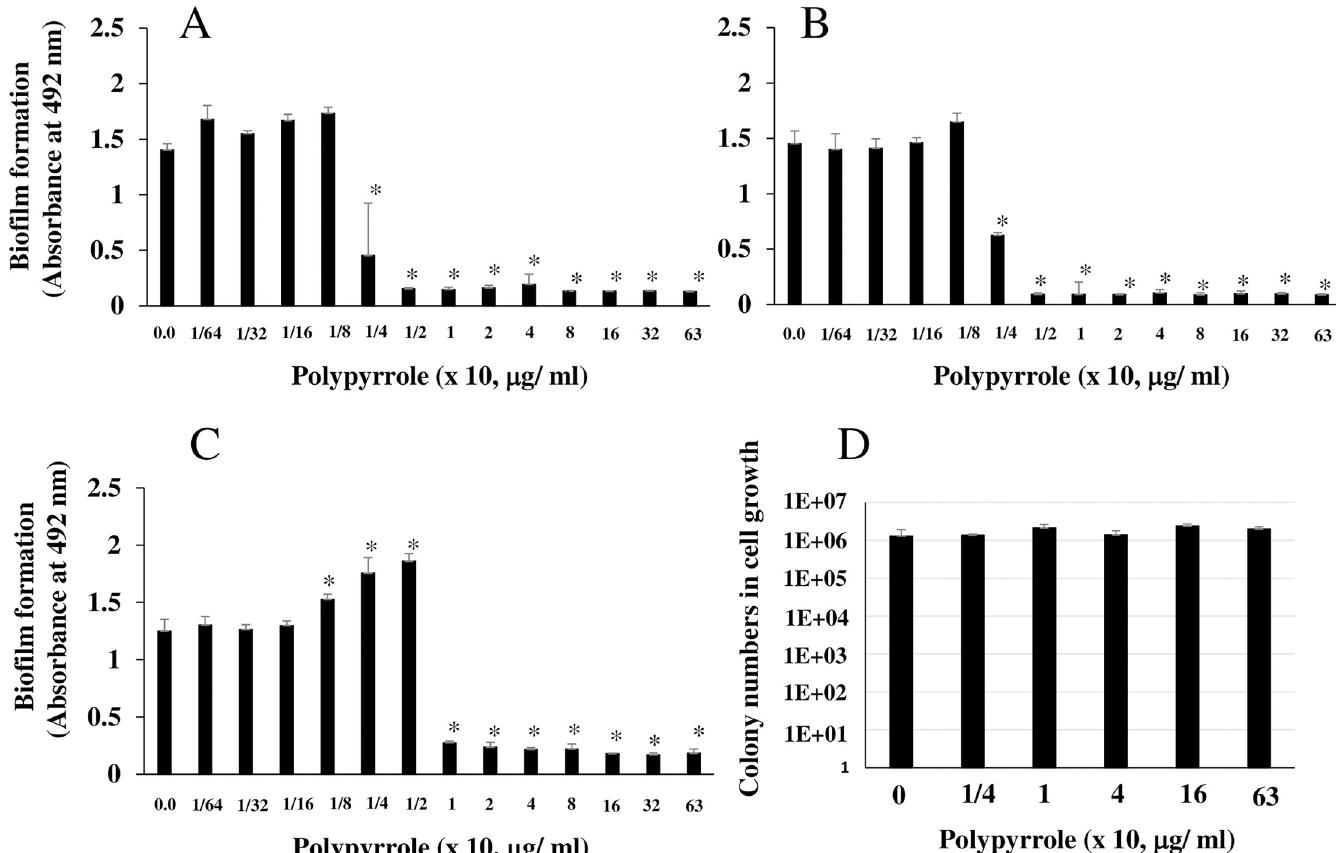
Fig 5. Biofilm formation by S . sanguinis induced by polypyrrole. The effects of polypyrrole on the biofilm formation of S . sanguinis were observed. Biofilm formation by S . sanguinis ATCC 10556 was quantitatively assessed with various concentrations of polypyrrole on human saliva-coated (A)-, uncoated (B), and BSA-coated (C) 96-well microtiter plates in TSB supplemented with 0.25% sucrose, including various concentrations of polypyrrole. (D) The growth of S . sanguinis was assessed by measuring the cell colonization numbers on BHI agar plates after 16 h of incubation in TSB supplemented with 0.25% sucrose, including various concentrations of polypyrrole. Small C indicated no polypyrrole as a control. The data indicated the mean ± SD of triplicate experiments. The independent experiments were performed 3 times, with similar results obtained in each. The asterisks indicated a statistically significant difference among multiple groups (ANOVA with Bonferroni correction; p- values < 0.05, various concentrations of polypyrrole vs no polypyrrole